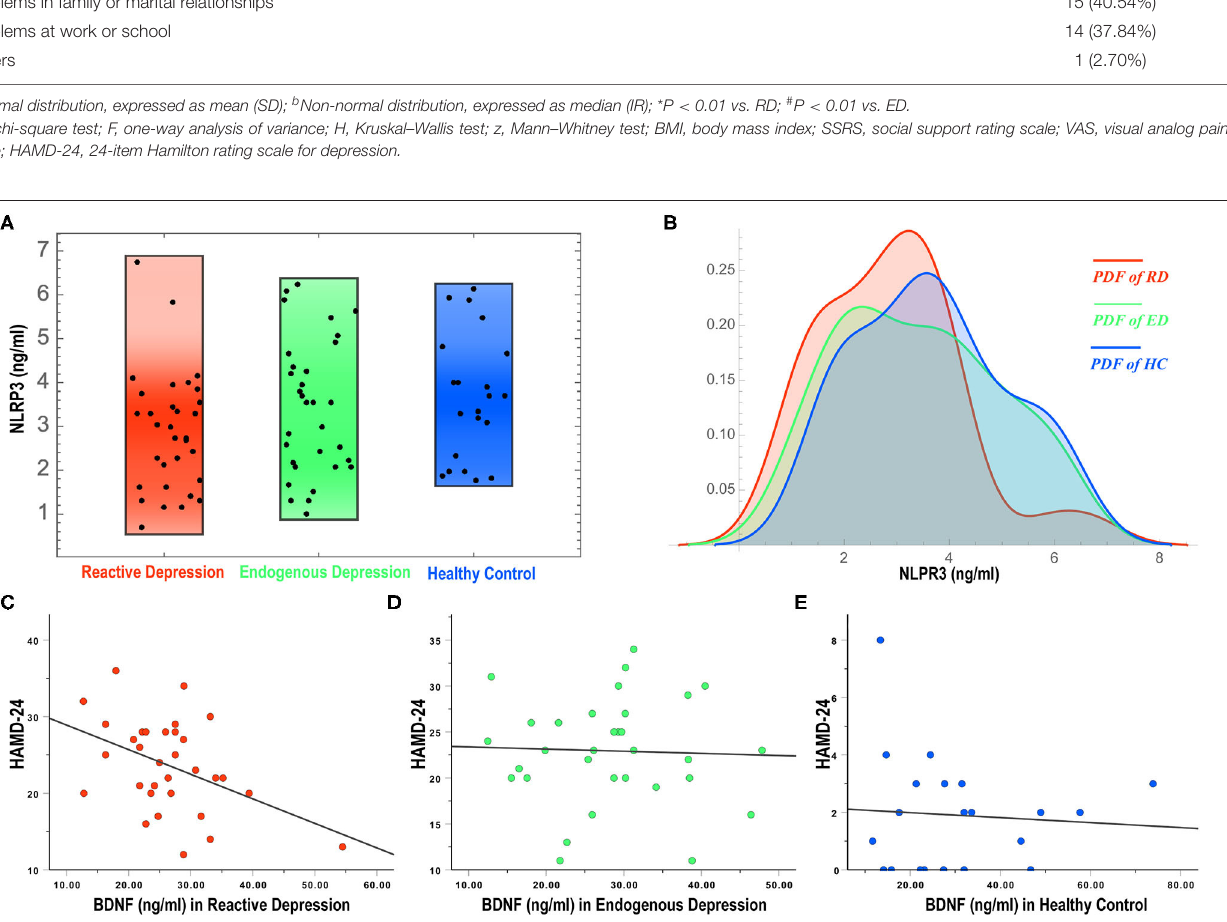
FIGURE 1 | NLRP3 expressions (A,B) and correlations of BDNF levels and HAMD-24 (C–E) in three groups. NLRP3, NOD-like receptor family protein 3; BDNF, brain-derived neurotrophic factor; RD, reactive depression; ED, endogenous depression; HC, healthy control; PDF, probability density function; HAMD-24, 24-item Hamilton rating scale for